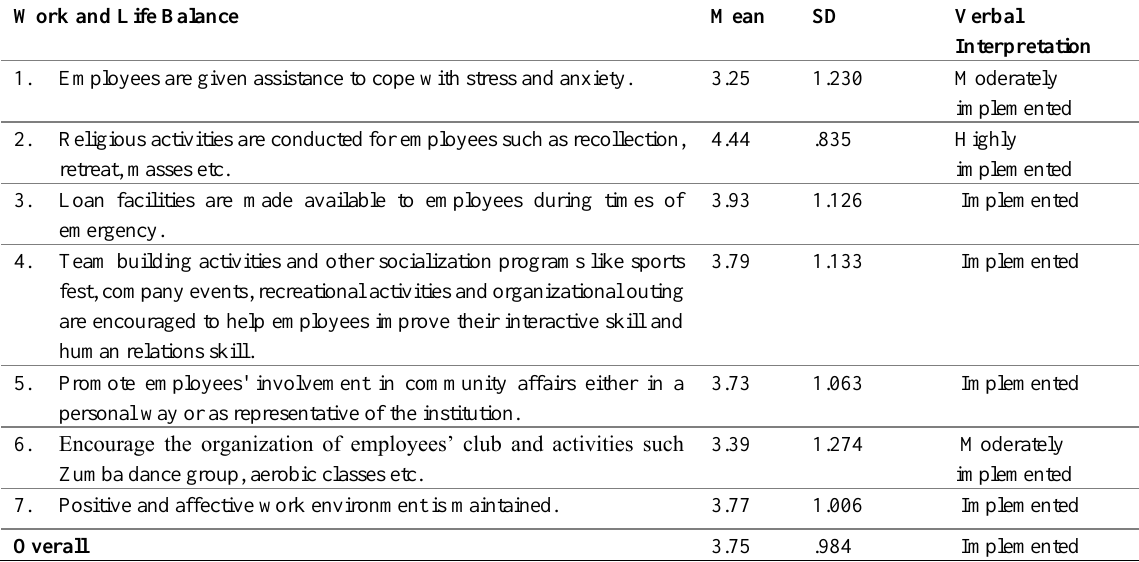
Table 6: Extent of Implementation of Leadership to Work Life Balance as Perceived by Respondents Work and Life Balance Mean SD Verbal